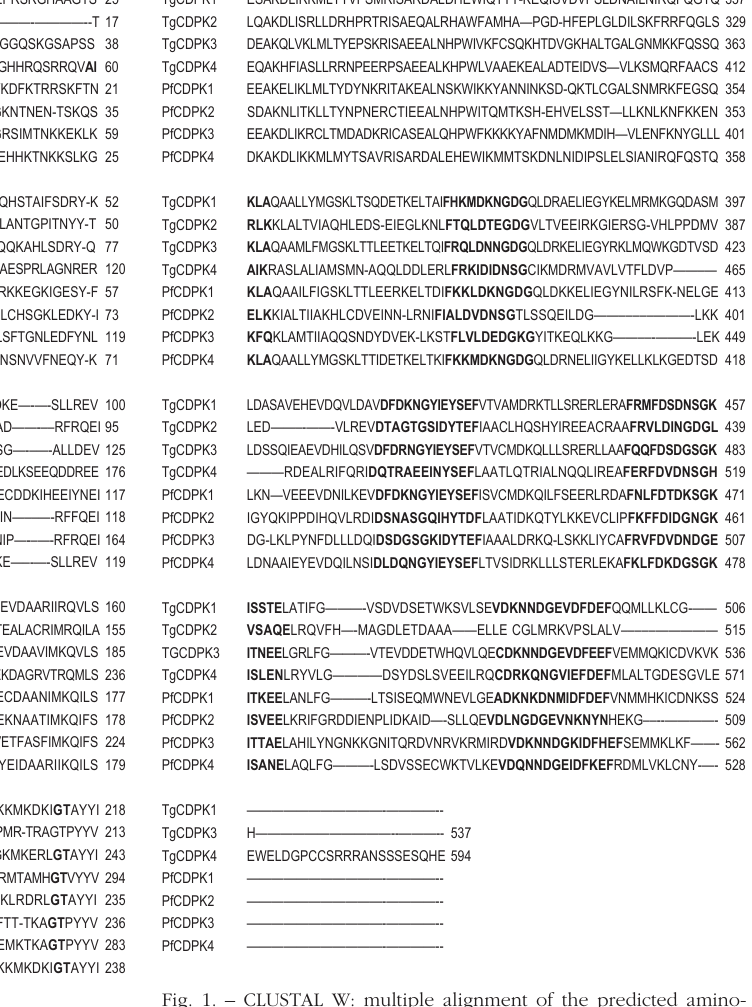
Fig. 1. – CLUSTAL W: multiple alignment of the predicted amino- acid sequence of the new TgCDPK4 (AJ488146) with the TgCDPK1 (AF333958), Tg CDPK2 (AF333959), TgCDPK3 (DQ205646) sequen- ces from Toxoplasma gondii . PfCDPK1 (A45472), PfCDPK2 (X99763), PfCDPK3 (AF106064) and PfCDPK4 (CAD50923) sequences from Plas- modium falciparum . The highly conserved amino-acid residues are shown in bold typeface. Sequences were aligned with the CLUSTAL W (1.8) multiple sequence alignment program.